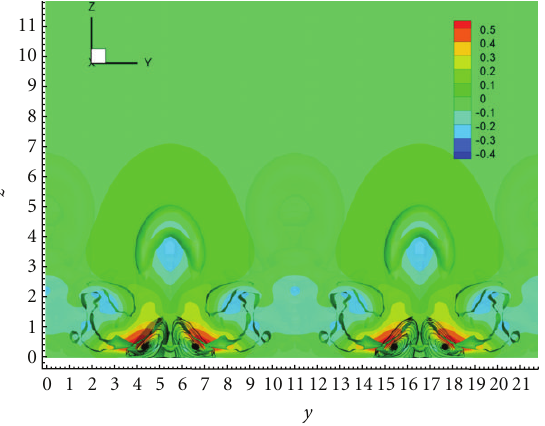
Figure 29: :Isosurface of λ 2 and velocity at x = 508 . 66.